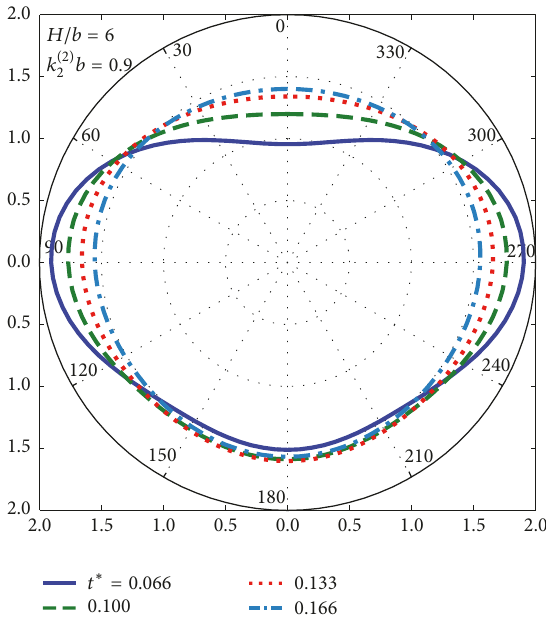
Figure 16: Tangential stress (𝜎 ∗ 𝜃𝜃 ) versus polar angle at 𝑟 = 𝑏 for different thicknesses (𝑡 ∗ ) for a tunnel in hard soil.